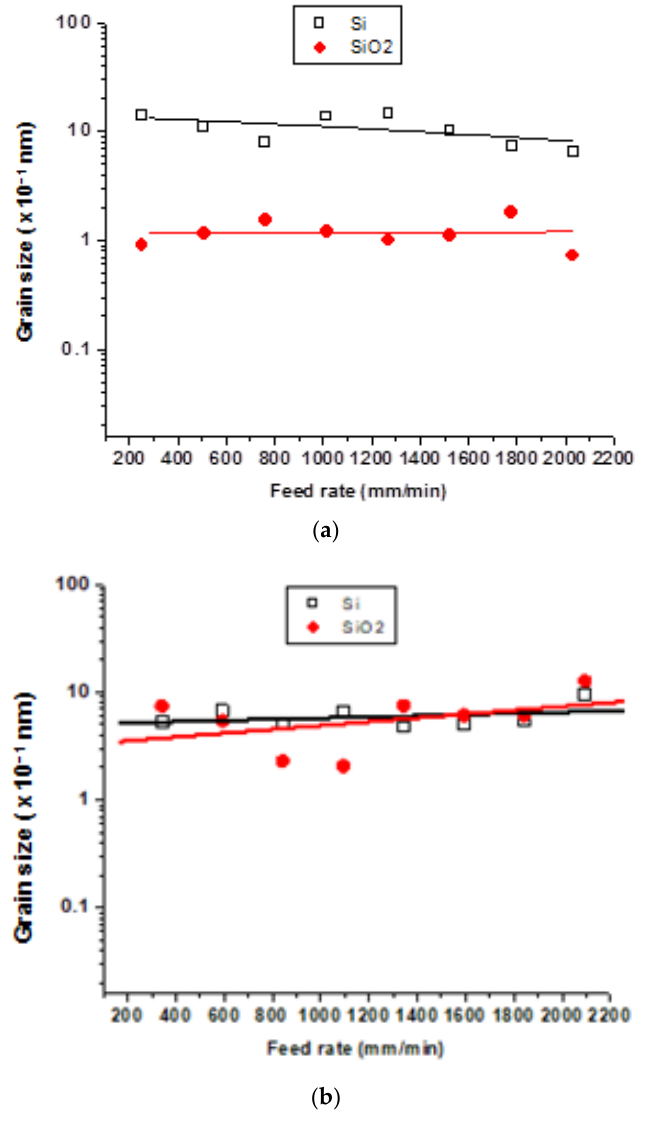
Figure 6. Grain size of Si and SiO 2 particles emitted at different feed rates for ( a ) white, and ( b ) Black granite (Canadian anorthosite) using 1000 rpm polishing rotation speed, 0.2 bar pressure and 60 grit